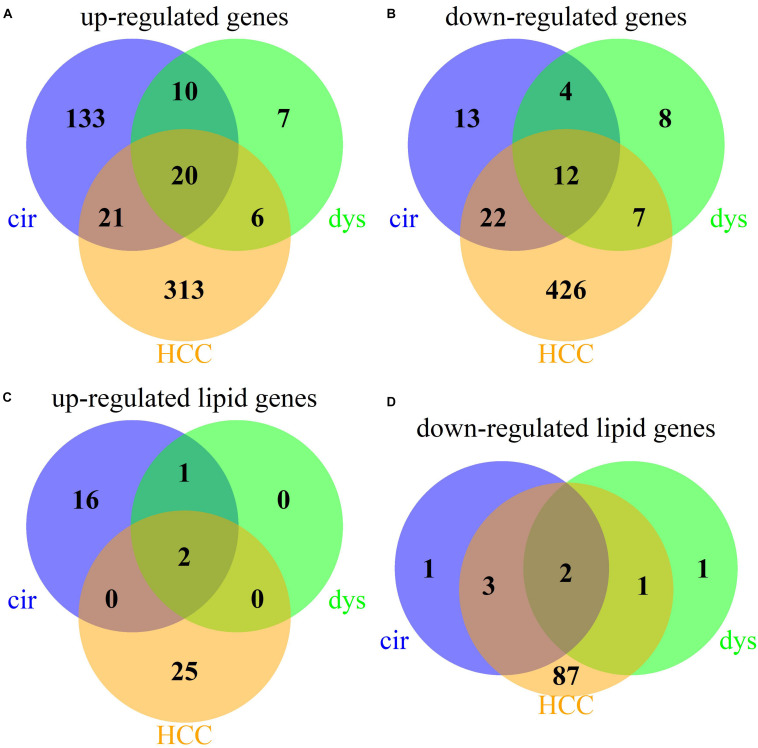
Venn diagrams for the DEGs in cirrhotic, dysplastic, and HCC samples. (A) Up-regulated genes. (B) Down-regulated genes. (C) Up-regulated lipid metabolic genes. (D) Down-regulated lipid metabolic genes.